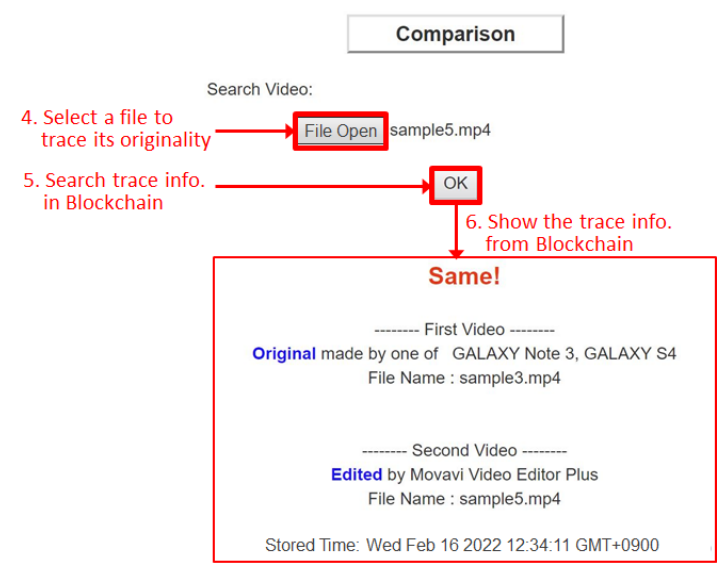
Figure 11. Procedure to search the integrity preservation trace with a hash of input file.